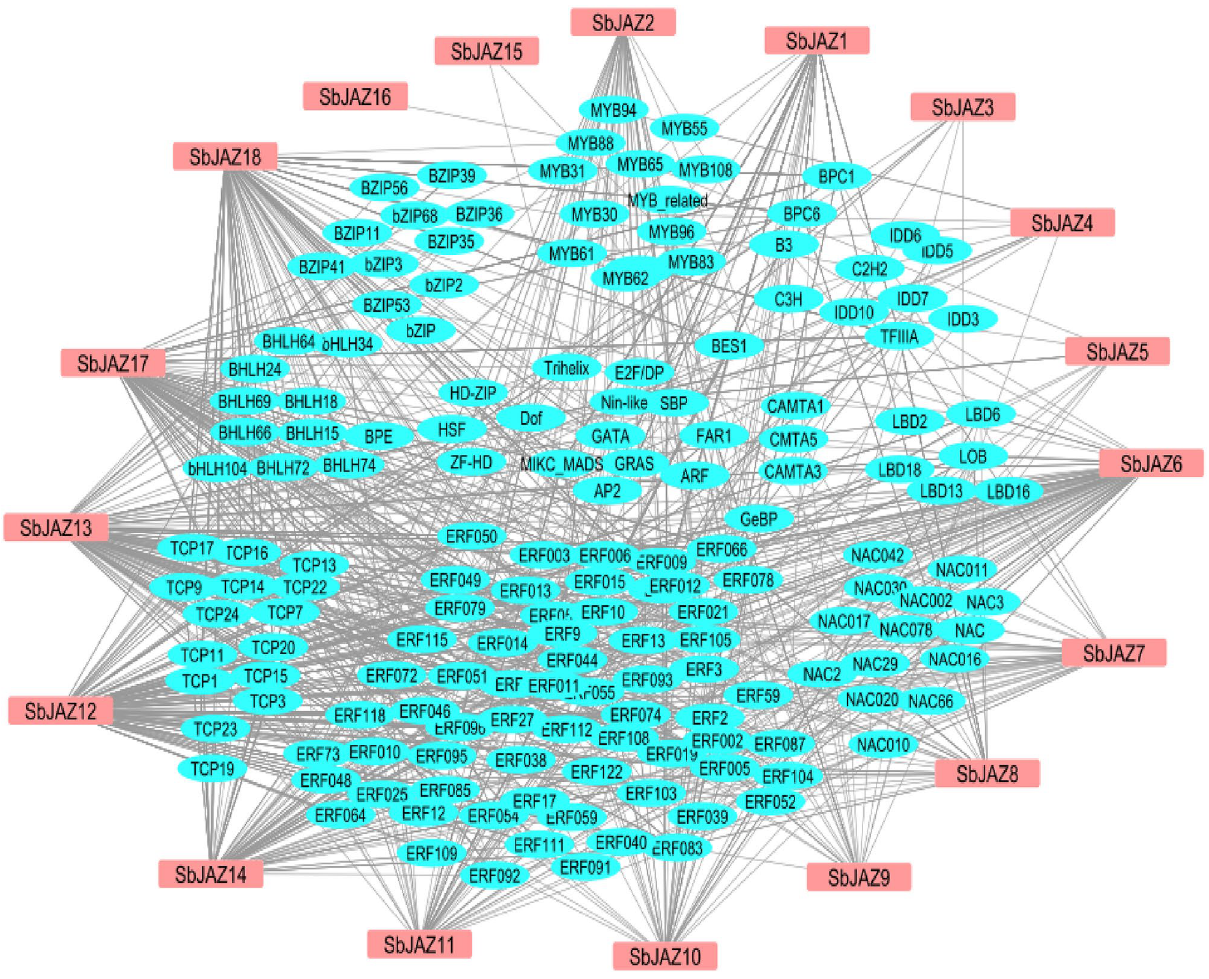
Figure 7. The putative transcription factor regulatory network of the SbJAZ genes. The network was constructed using the PTRM tool and Cystoscope.